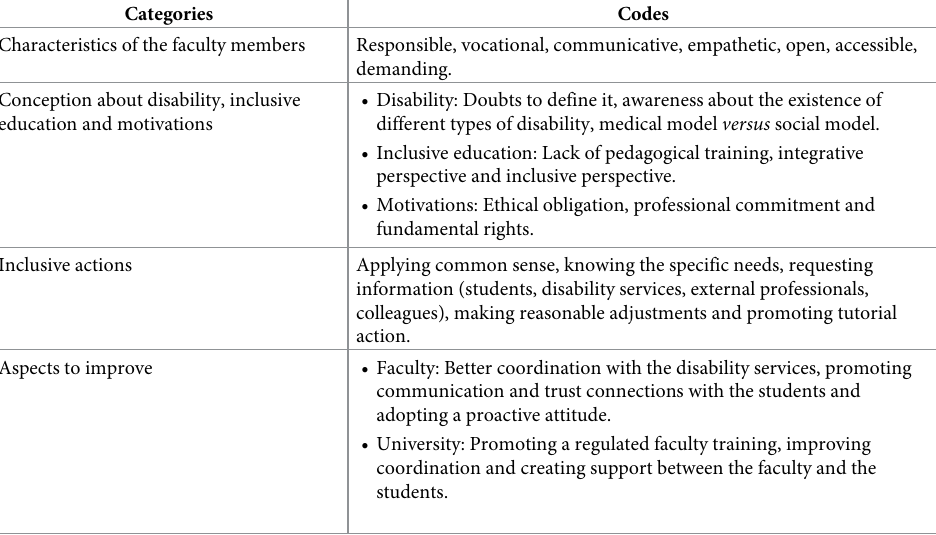
Table 2. Categories and codes